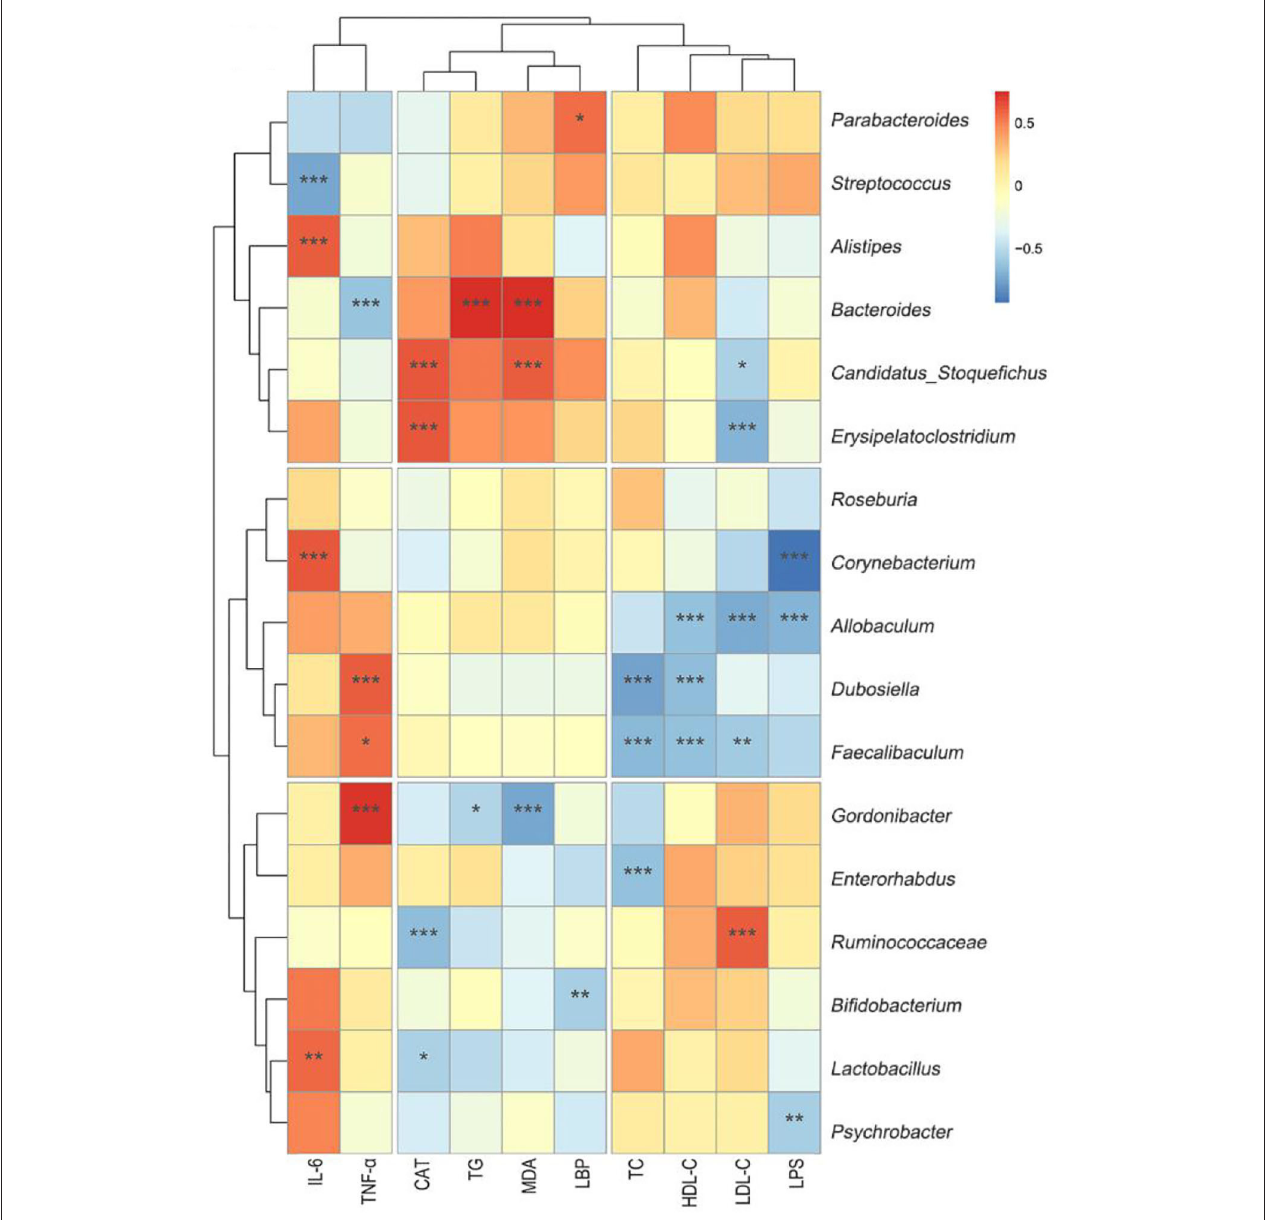
FIGURE 8 | Heat-map of the correlation analysis between different biochemical indicators and genus microbiota. Hierarchical clustering by average linkage of the significantly differentially affected genus as compared HF + Fn041 with the HF group. The differentially affected genus was identified with edgeR; the threshold was set to FDR < 0.05. The color bar indicates the correlation of the indicators (positive correlation, red; negative correlation, blue). * p < 0.05; ** p < 0.01; *** p < 0.001 using Spearman correlation. ( n =